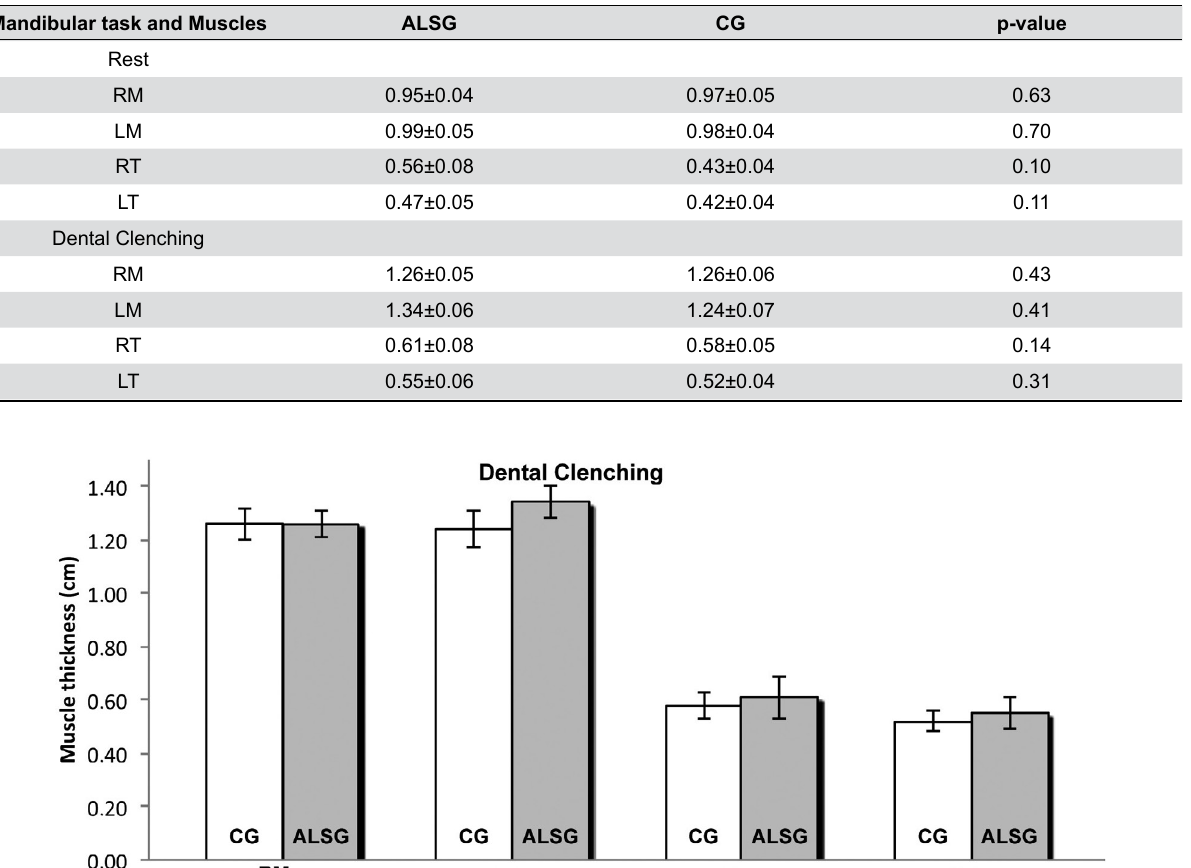
Table 4- Comparison of the mean masticatory muscle thickness (cm) during mandibular task according to the groups. ALSG: Amyotrophic lateral sclerosis group; CG: control group; SD: standard deviation; RM: right masseter; LM: left masseter; RT: right temporal; LT: left